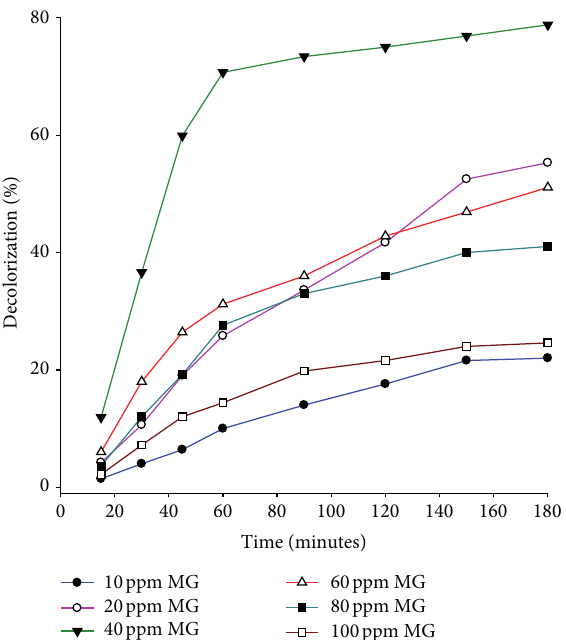
F 9: Effect of the initial dye concentration on decolorization efficiency of MG; 0.6gL